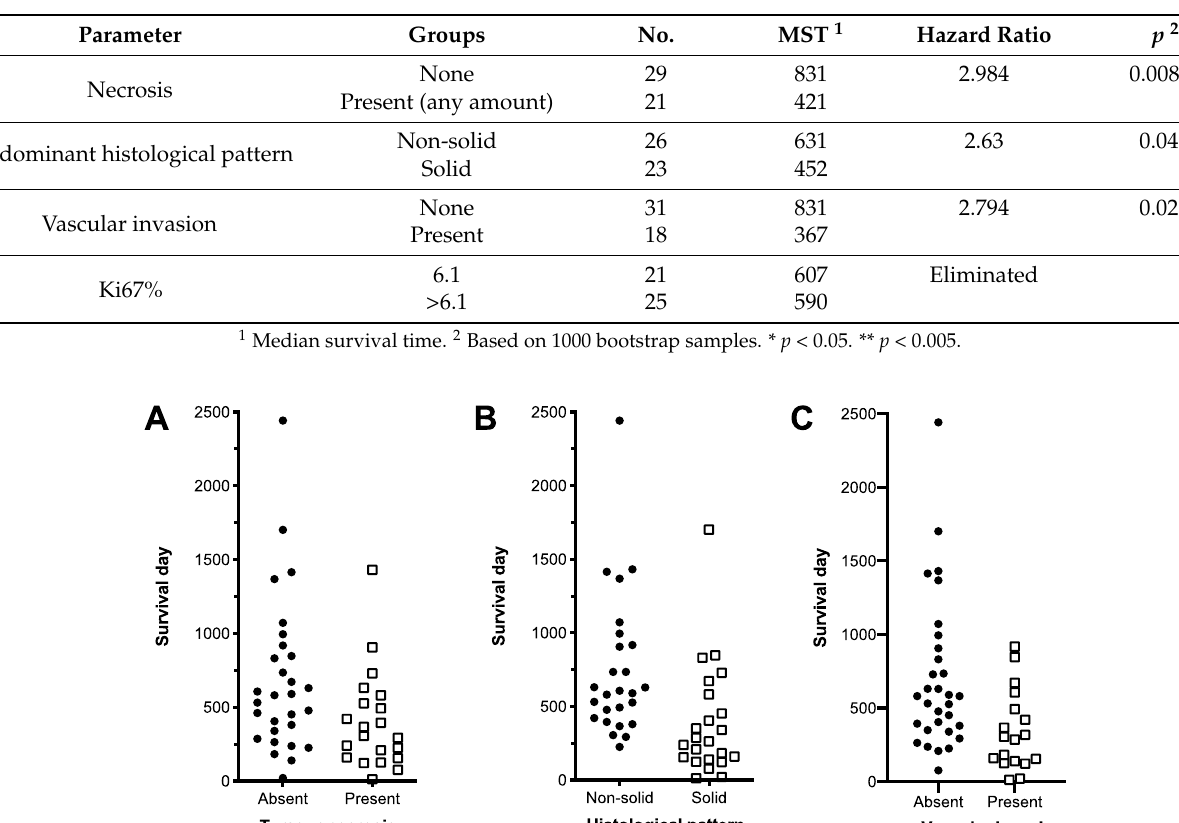
Table 6. Model generation for histological variables' effects on survival.